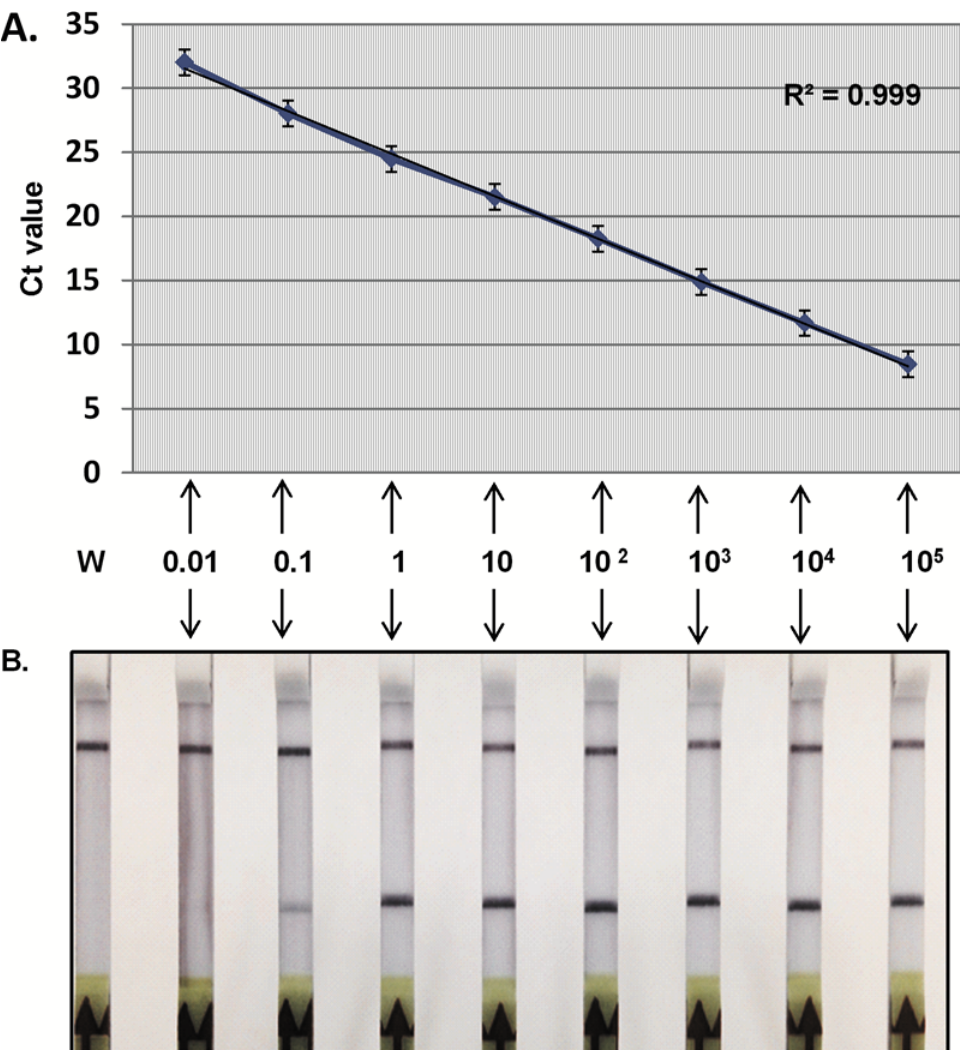
Fig 1. Sensitivity of RPA-LF to detect L . viannia spp . compared with real-time PCR (the current gold standard). Ten-fold serial dilutions of parasite DNA, extracted with Qiagen DNeasy blood and tissue kit, were amplified by qPCR (SYBRgreen) (A) or RPA-LF (B). W = water. The control band is the upper band, while the test band is the lower